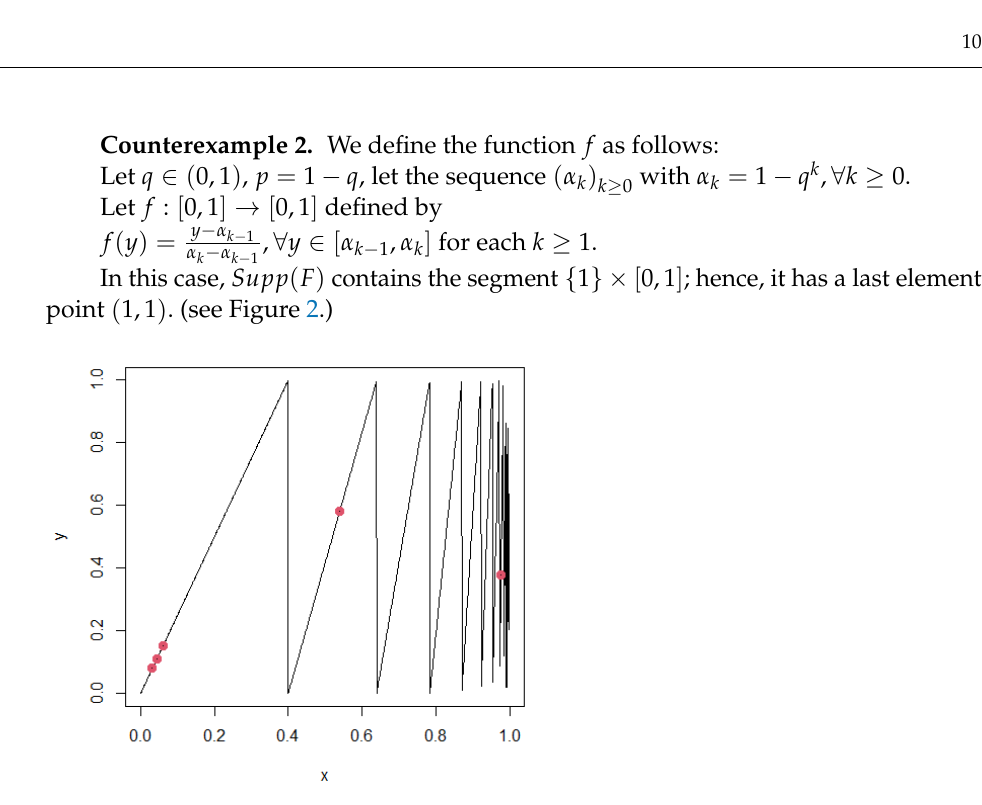
Figure 2. f is not L-acceptable. The set of marked points has a first element, but does not have a last